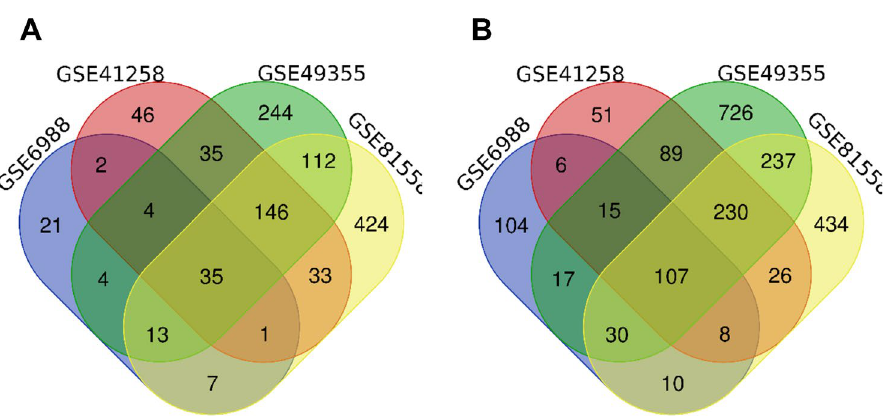
Figure 2. (SET 2) Venn diagram showed 142 DEGs distinguishing primary tumor tissues and normal colon tissues in both GEO datasets. ( A ) 35 Upregulated genes ( B ). 107 Downregulated genes. DEG differentially expressed gene, GEO Gene Expression